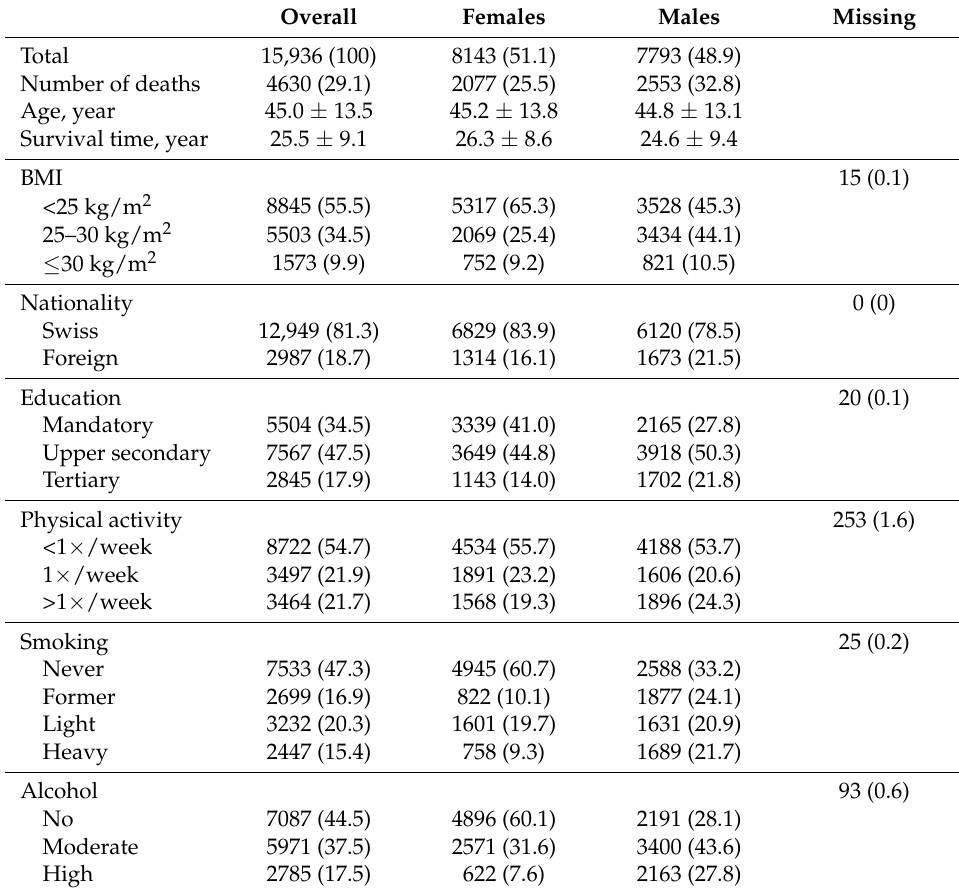
Table 1. Characteristics of the study participants by sex 1